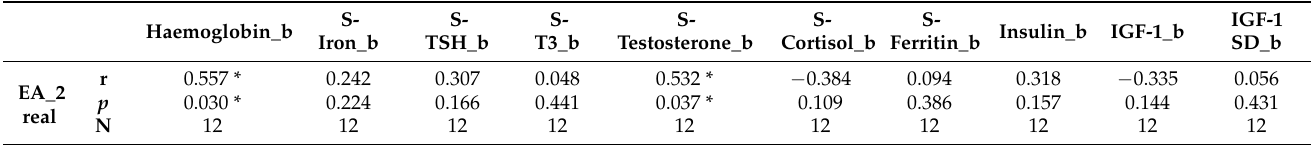
Table 2. Blood parameters correlations to EA at the end of the intervention.